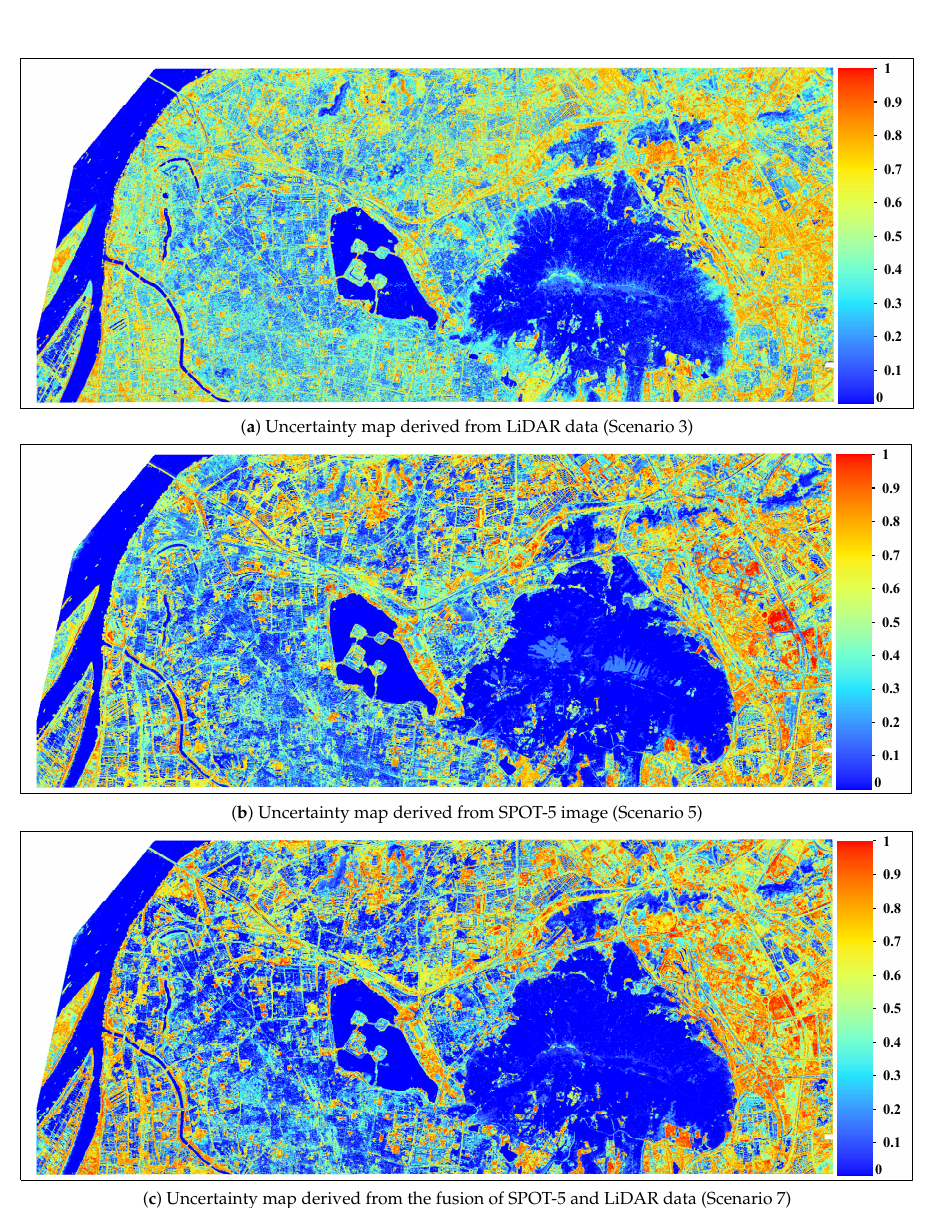
Figure 8. Uncertainty maps of the classification results obtained by different scenarios of input